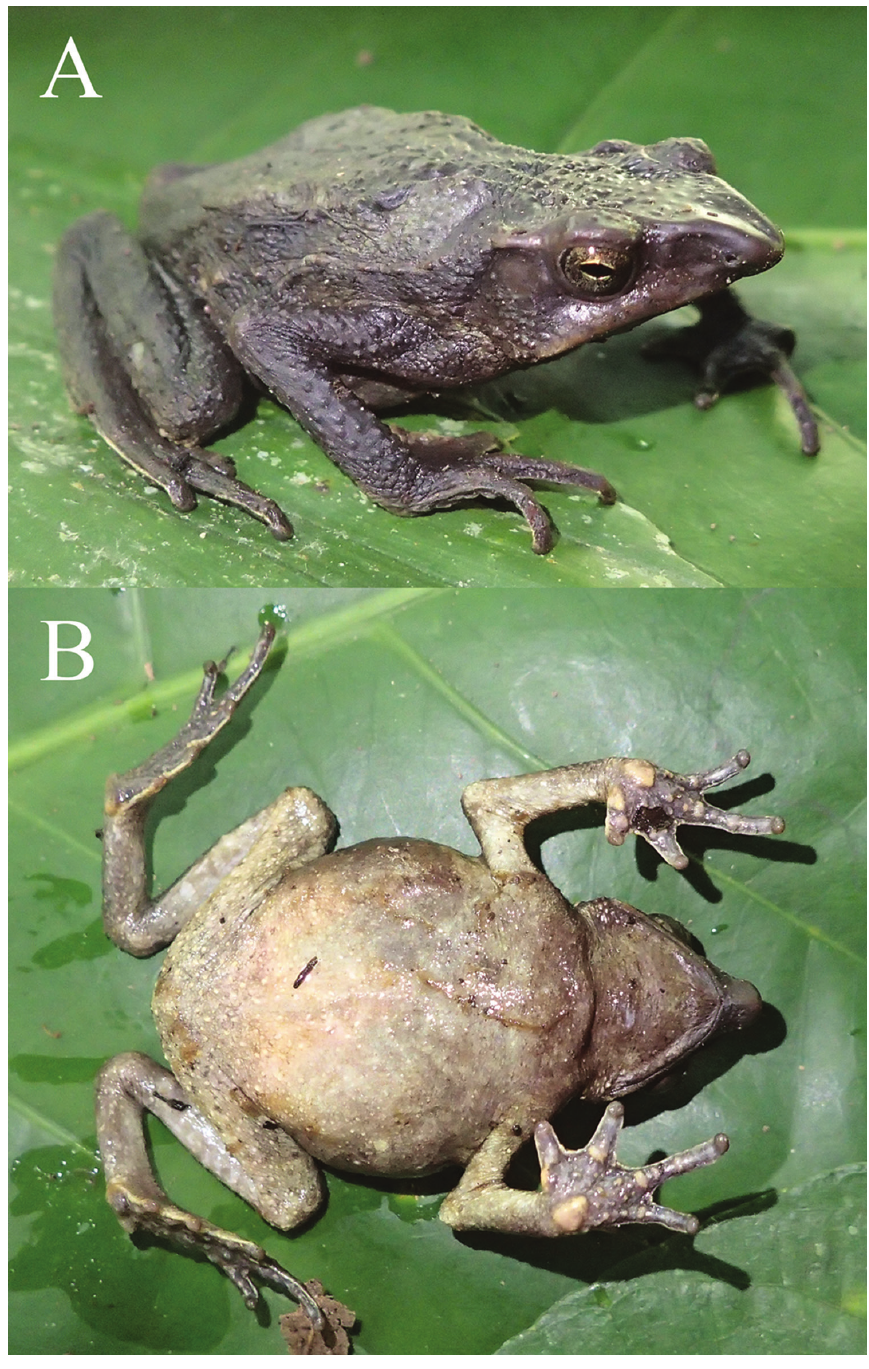
Figure 6. Holotype of Rhinella lilyrodriguezae sp. n. (MUSM 32204, SVL = 58.3 mm) in life. A Latero- dorsal and B ventral views of the coloration during the day. Photos by K.